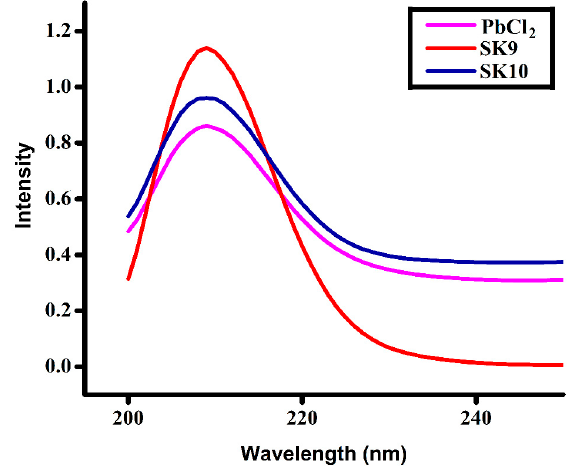
Figure 3. UV spectra of synthesized perovskites ( SK9 – SK10 ) and PbCl 2.